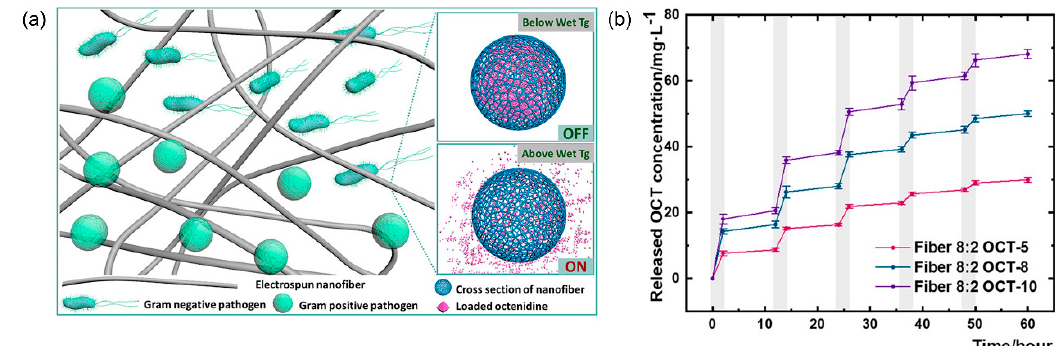
Figure 10. ( a ) Schematic hypothesis of T g − triggered OCT release from NFs. ( b ) In vitro pulsewise drug release from NFs. Reproduced with permission from [90], CC BY − NC − ND license, Copyright © 2021 The Authors, Published by American Chemical Society.